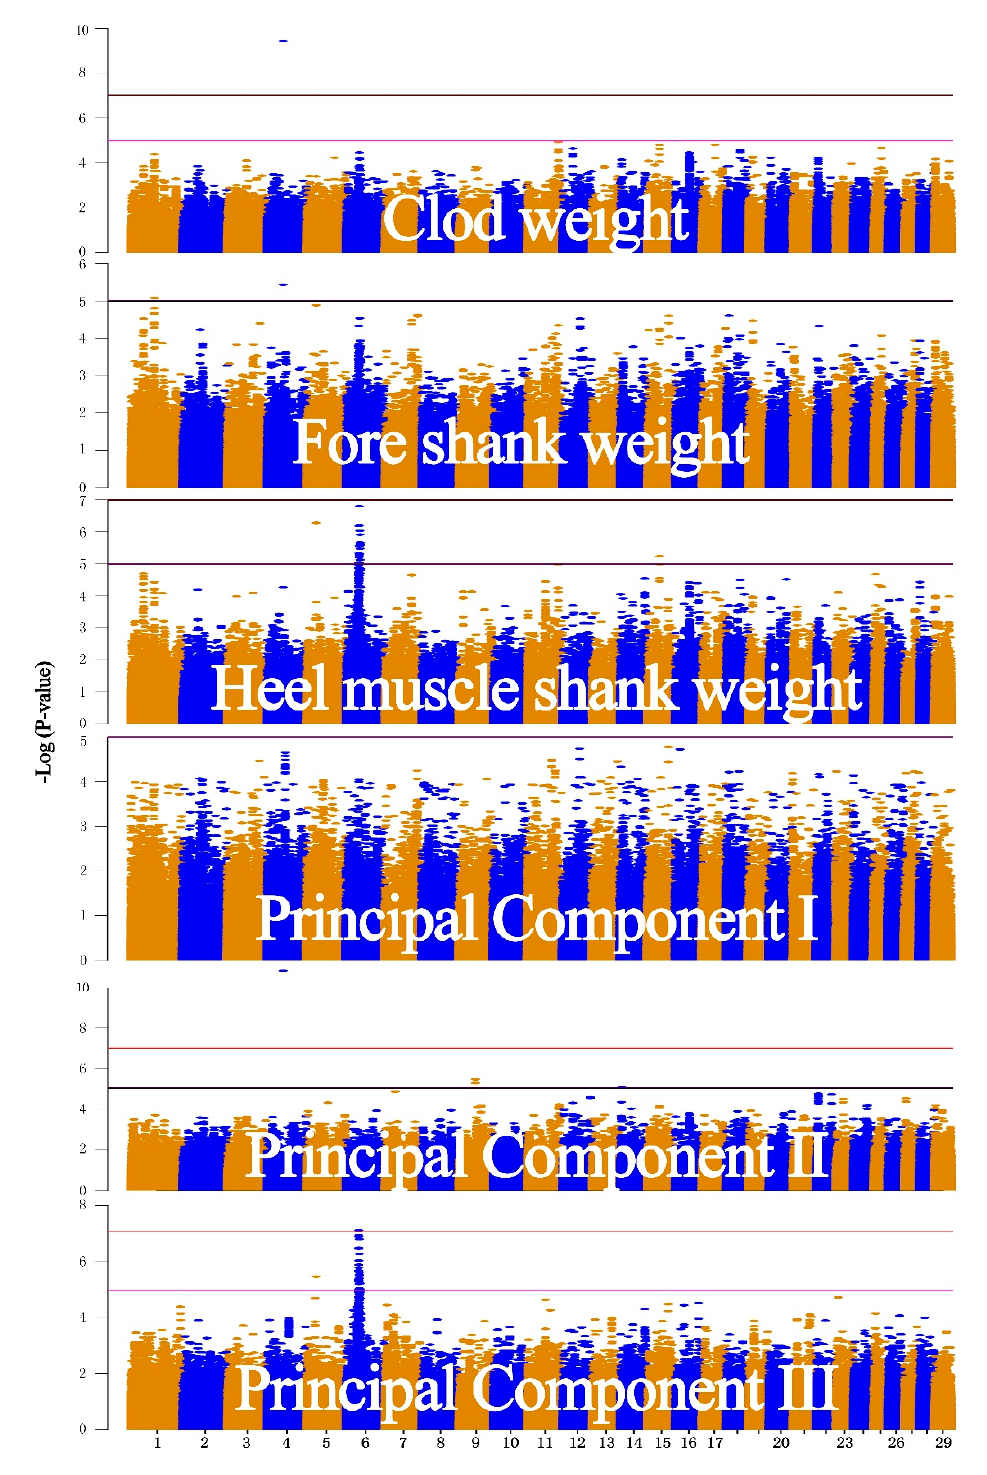
Figure 5. Manhattan plot of the association study results of real cattle data. The three phenotypes are clod weight (CW), fore shank weight (FSW), and heel muscle shank weight (HMSW). The significant level is 10 − 7 , represented by the red line, and the suggestive significant level is 10 − 5 , represented by the pink line.